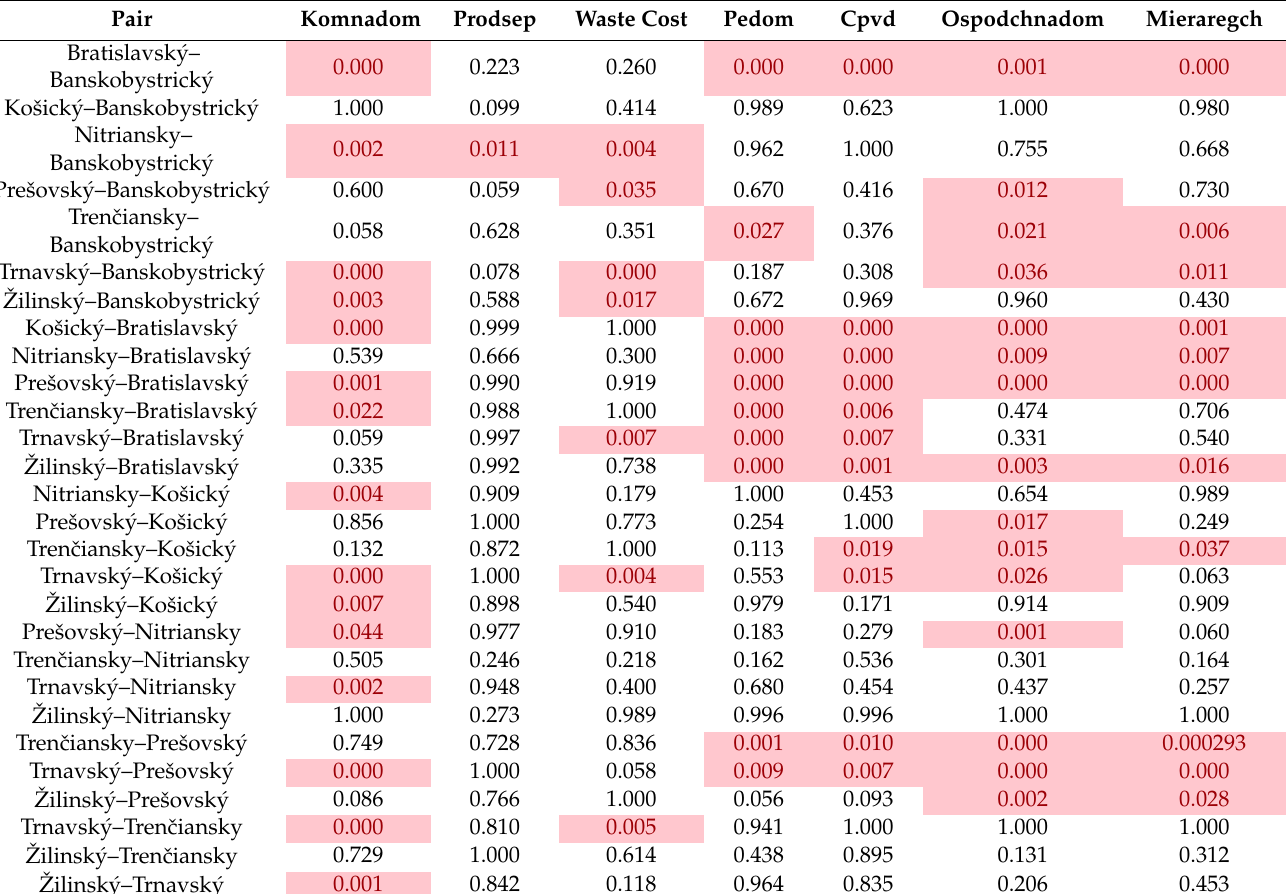
Table 6. Results of pair comparison of indexes for